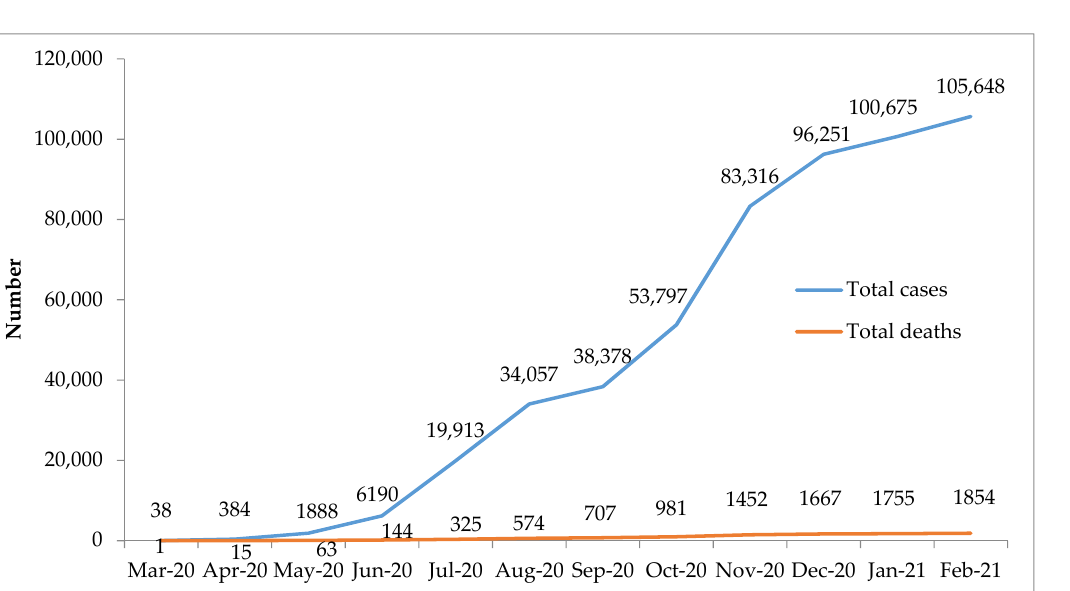
Figure 1. Cumulative number of COVID-19 cases and deaths in Kenya between March 2020 and February 2021, as reported to the World Health